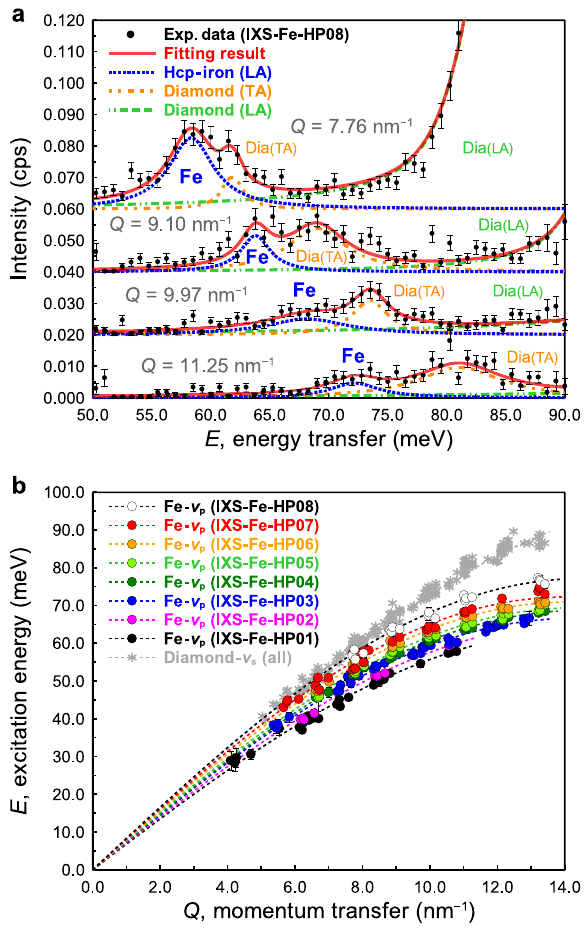
Fig. 1 | Inelastic X-ray scattering (IXS) spectra and dispersion curves of hex- agonal close-packed (hcp) iron. a IXS spectra of hcp-iron at 13.87gcm − 3 (corre- sponding to 310GPa 3 ) for different momentum transfers ( Q =7.76, 9.10, 9.97, and 11.25nm − 1 ) at ambient temperature by an offset of 0.02cps in the vertical axis for clarity.Thedatawere fi twithpeaksforlongitudinalacoustic(LA)modeofhcp-iron (blue), the transverse acoustic (TA) and LA mode of diamond (orange and green). b The dispersion curves of hcp-iron determined at pressures from 154 to 310GPa basedon theequationof stateof hcp-iron 3 .The fi ttedresults weregiveninTable 1. Thedataformomentumtransfer Q andenergytransfer E ofTAmodeofdiamondis plotted as grey asterisks. The error bars represent one standard deviation (1 σ ) uncertainties and are mostly smaller than the